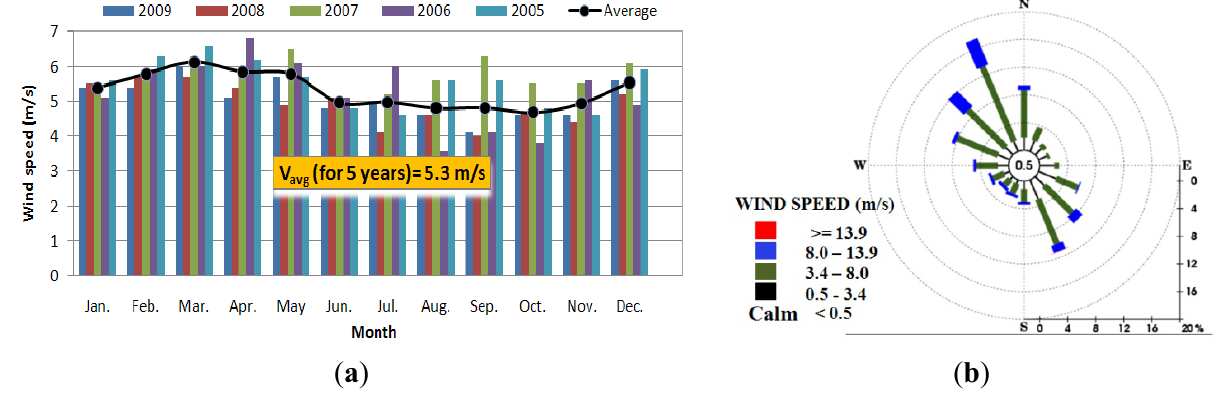
Figure 2. Wind record in Jindo area from KMAC [12]: ( a ) wind speed record over the last five years; ( b ) wind rose in